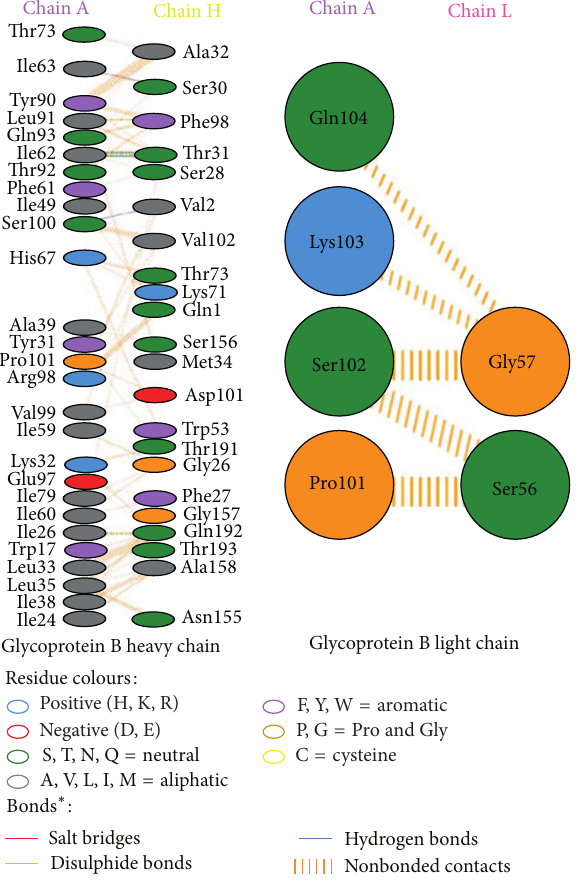
Figure 4: Interaction of glycoprotein B and motavizumab showing interaction of residues with heavy and light chain through various bonds ∗ . Table 2: Interacting oligopeptides from proteins and their